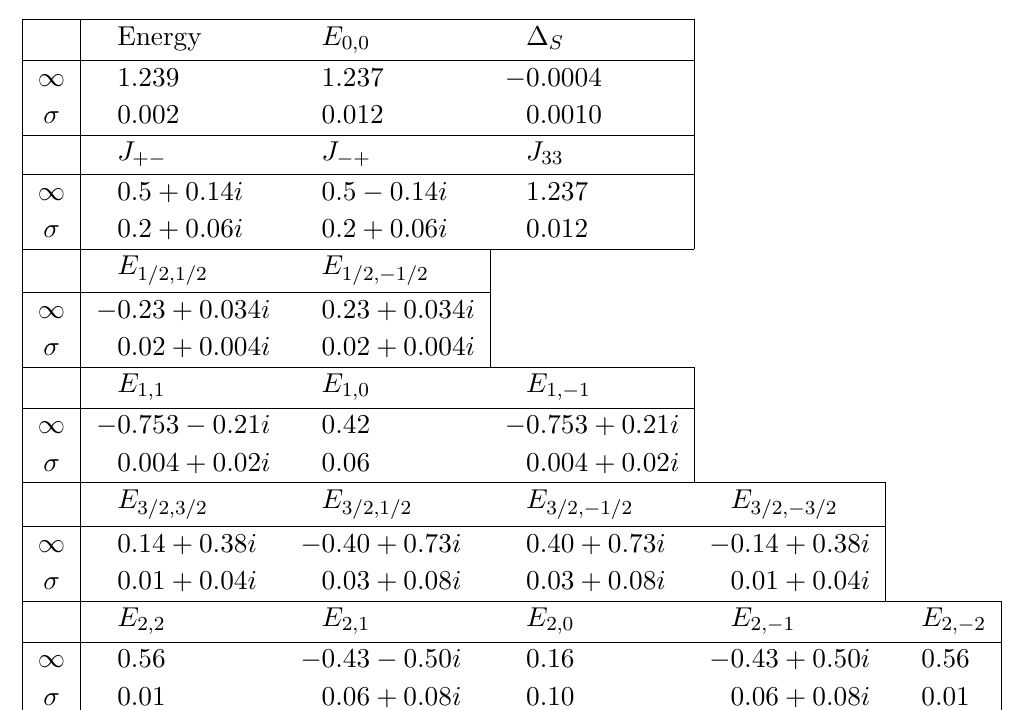
Table 26 . Extrapolations of gauge invariants of exotic solution number 6534 in the k = 8 model with J = 2 boundary